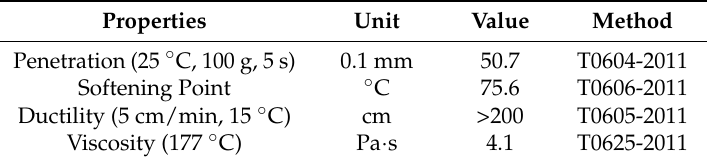
Table 2. Properties of styrene-butadiene-styrene (SBS)